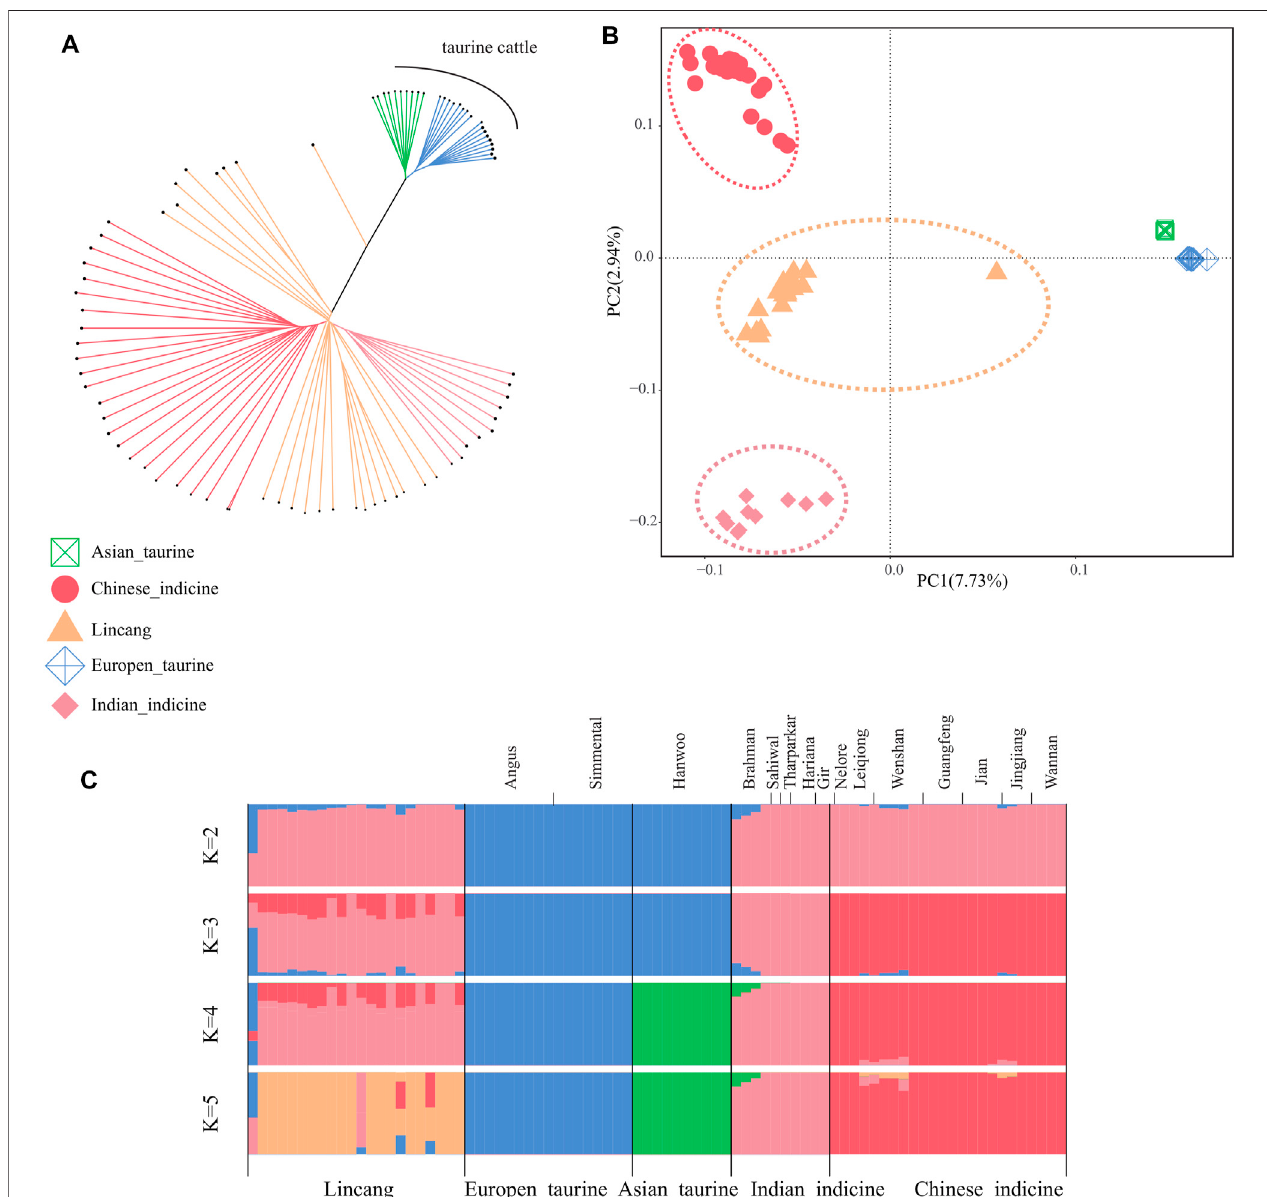
FIGURE 2 | Population structure and relationships of Lincang cattle. (A) Neighbor-joining tree of the relationships between the cattle group. (B) Principal componentanalysisofthecattlegroup. (C) Model-basedclusteringofthecattlegroupusingADMIXTURE(withK=2toK=5).Breedsarecoloredbygeographicregions and labeled with breed